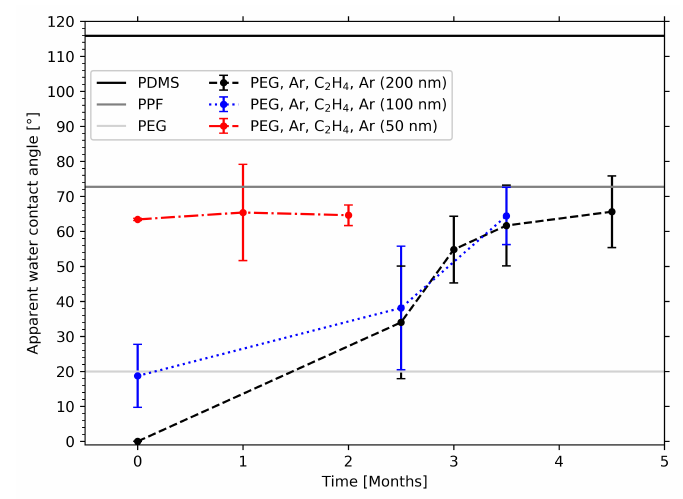
Figure 10. Temporal evolution of the apparent water contact angles on the Ar-O 2 samples and the Ar-C 2 H 4 -Ar samples with plasma-polymerized film (PPF) thicknesses of 50, 100 and 200nm. For comparison, the WCA values for pure PDMS, the plasma-polymerized film and PEG are drawn as straight